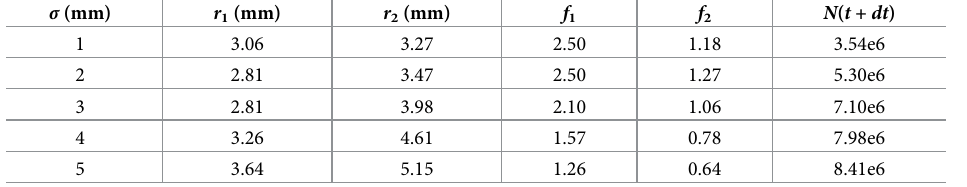
Optimal two-step profile for one fraction of radiation with exponential growth and death. σ is the standard